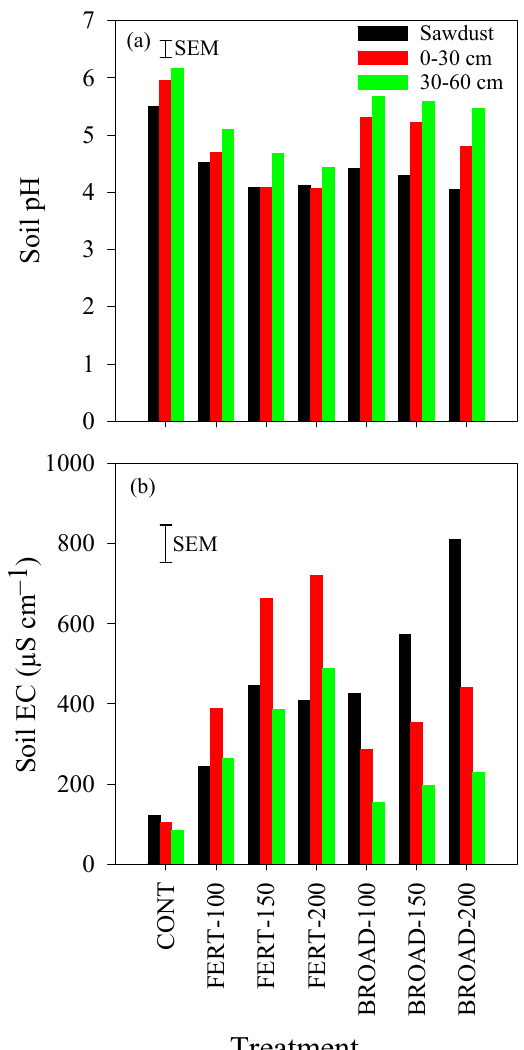
Figure 5. ( a ) Soil pH and ( b ) electrical conductivity (EC) at 0–30 cm and 30–60 cm soil depth and in the sawdust mulch layer with annual applications of N through fertigation (FERT ‐ 100, 100%; FERT ‐ 150, 150%; FERT ‐ 200, 200%) and broadcast (BROAD ‐ 100, 100%; BROAD ‐ 150, 150%; BROAD ‐ 200, 200%) methods to highbush blueberry ( Vaccinium corymbosum ) in fall 2018. Error bars represent the standard errors of the means (SEM) for comparing all values (n = 28 and df = 21).